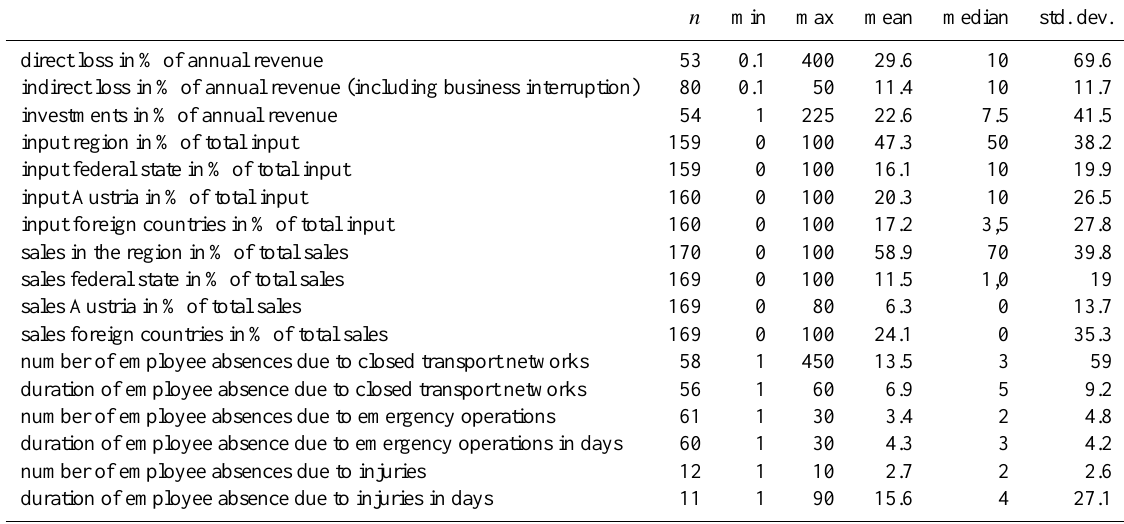
Table A2. Main sample characteristics of quantitative